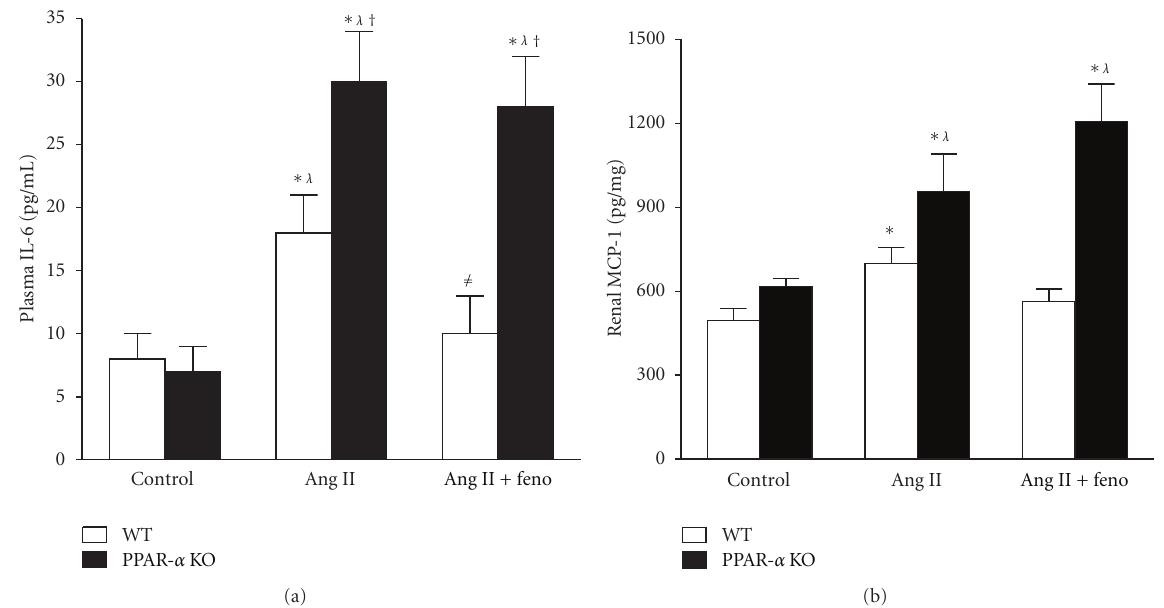
Figure 3: Plasma interleukin-6 levels ( n = 8 per group) and renal MCP-1 levels ( n = 5 per group) in control, Ang II-infused and Ang II- infused + fenofibrate-treated WT and PPAR- α KO mice. ∗ indicates a significant increase versus control WT. λ indicates a significant increase versus control PPAR- α KO. † indicates a significant increase versus Ang II-infused WT mice. / = indicates a significant decrease versus Ang II-infused WT or PPAR- α KO mice.